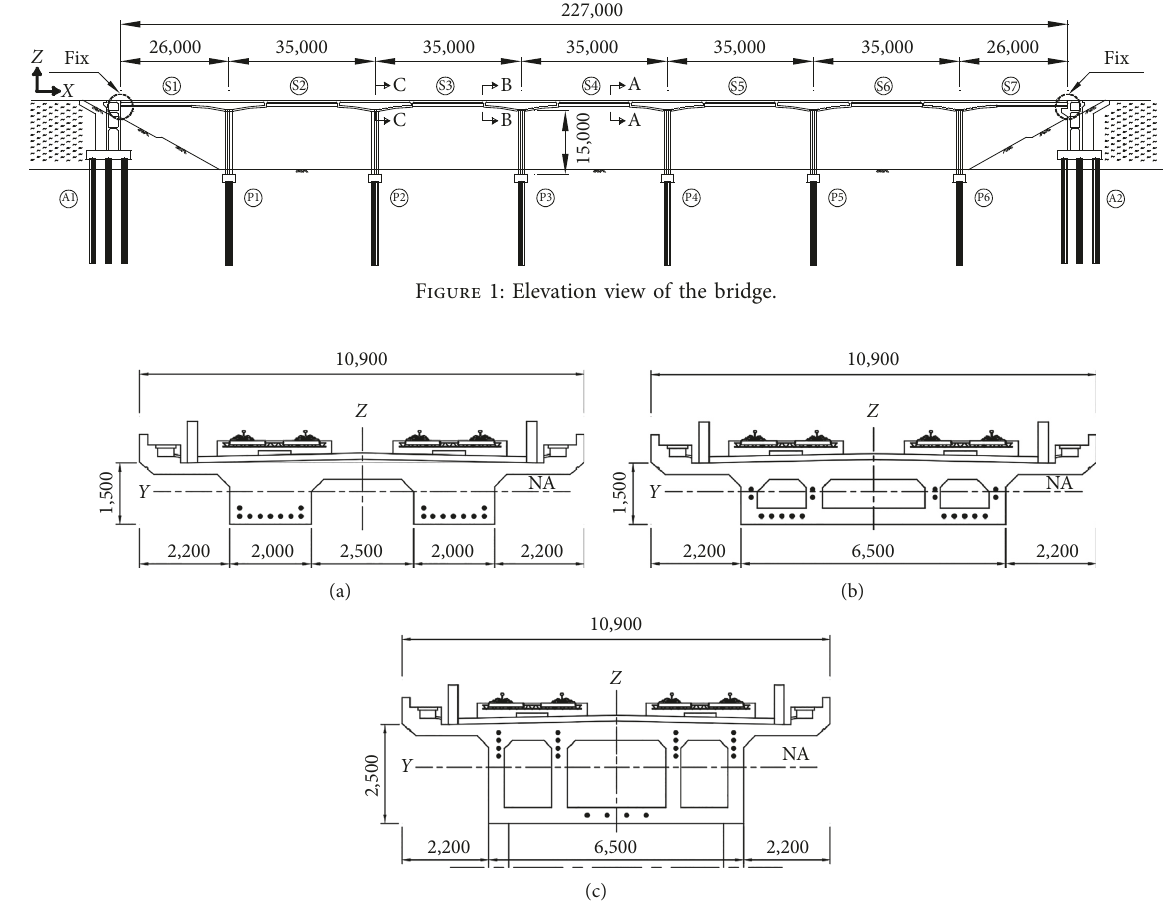
Figure 2: Cross section of the superstructure (unit: mm). (a) Section A-A. (b) Section B-B. (c) Section C-C.